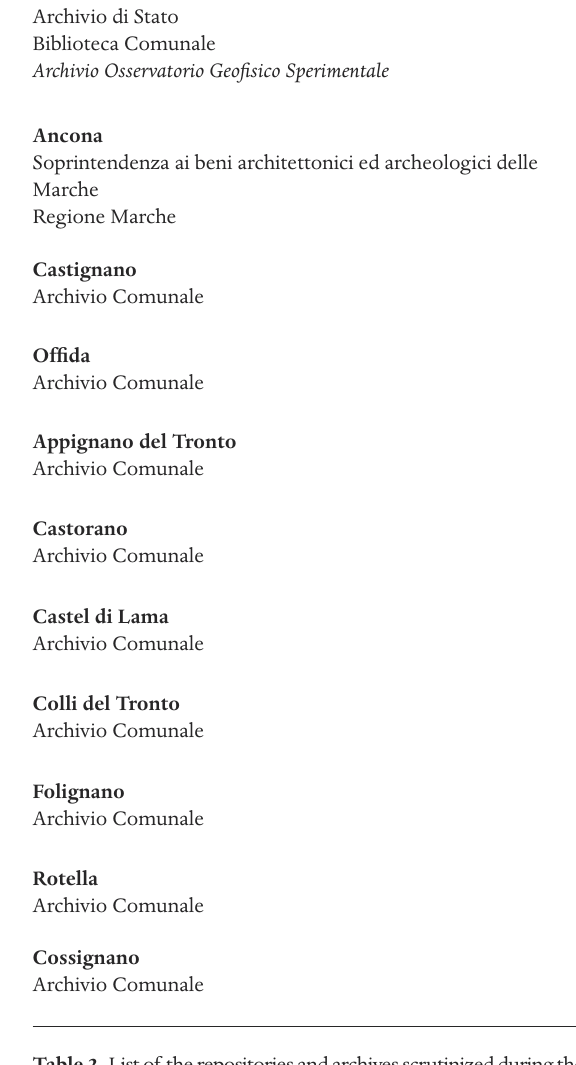
Table 2. List of the repositories and archives scrutinized during the re- search activity. In Italic those visited by the previous Authors.